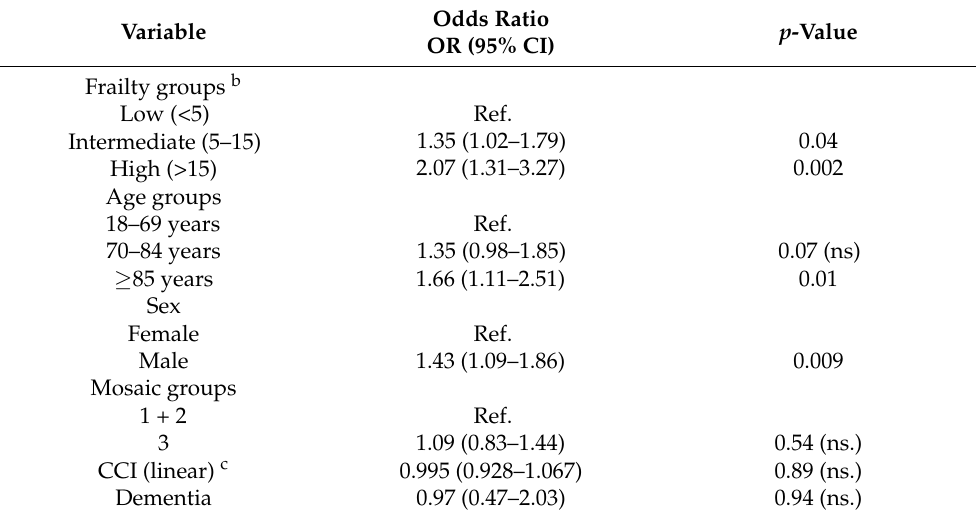
Table 4. Odds ratios (ORs) (multivariable analysis model 2 , nursing home residents excluded) for